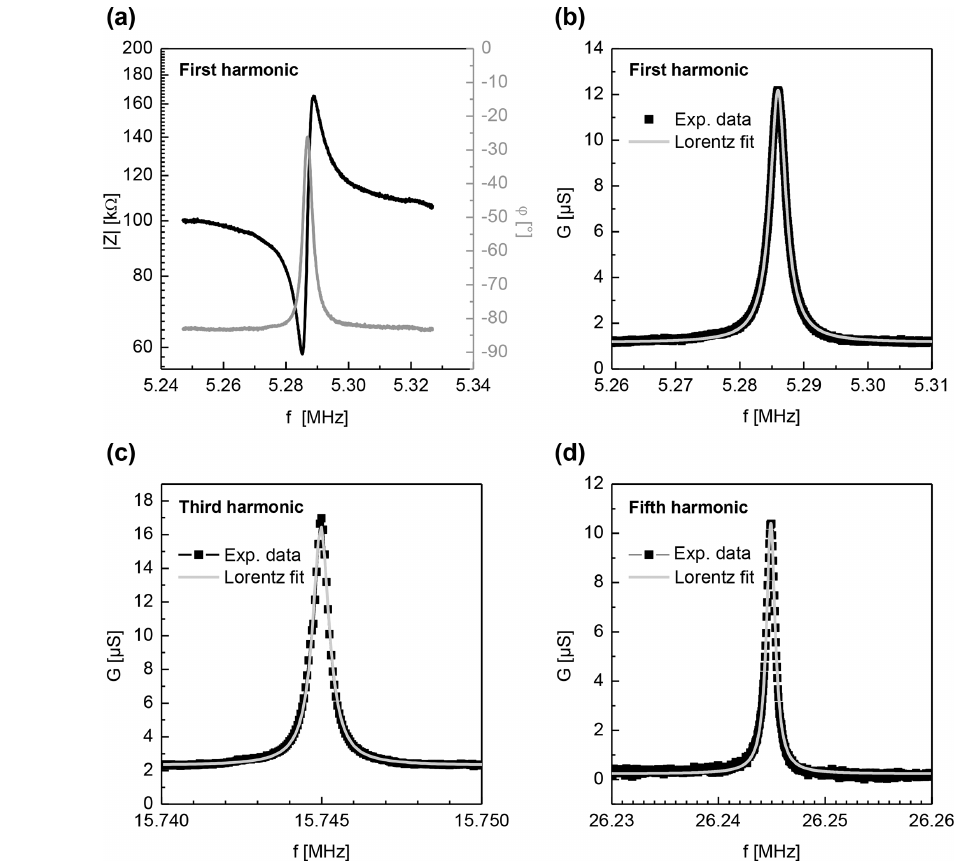
Figure 7. Examples of impedance spectra of the nearly monolithic resonator excited via electrodes aligned along the x axis. All spectra are obtained at a temperature of 990 ◦ C. Panel (a) shows the complex impedance | Z | (black curve on left axis) and the phase ϕ (grey curve on right axis) for first harmonic. Panel (b) shows the conductance G (experimental data, black dots) for the same data set and a corresponding Lorentz fit (grey curve), used for the calculation of the Q factor. Panels (c) and (d) are equivalent to (b) , depicting the conductance of the for third and fifth harmonics,